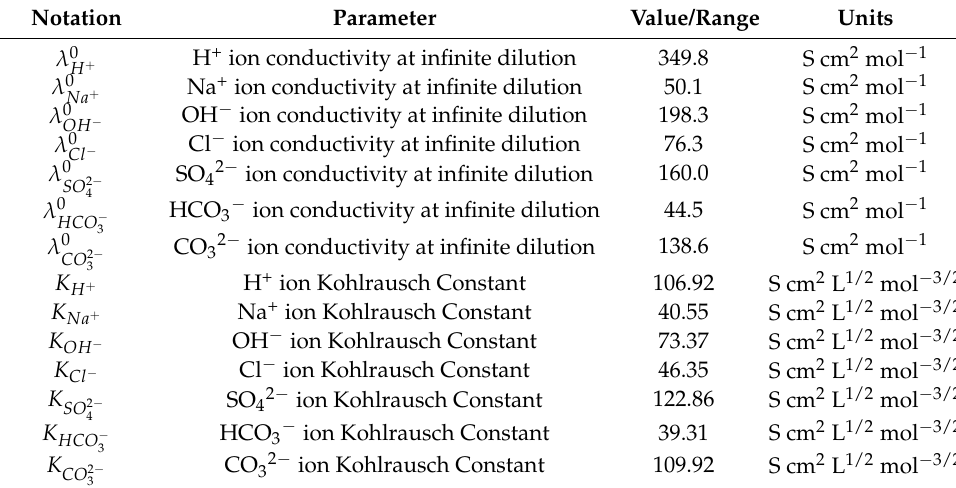
Table A2. Values used in calculating potential drop in the